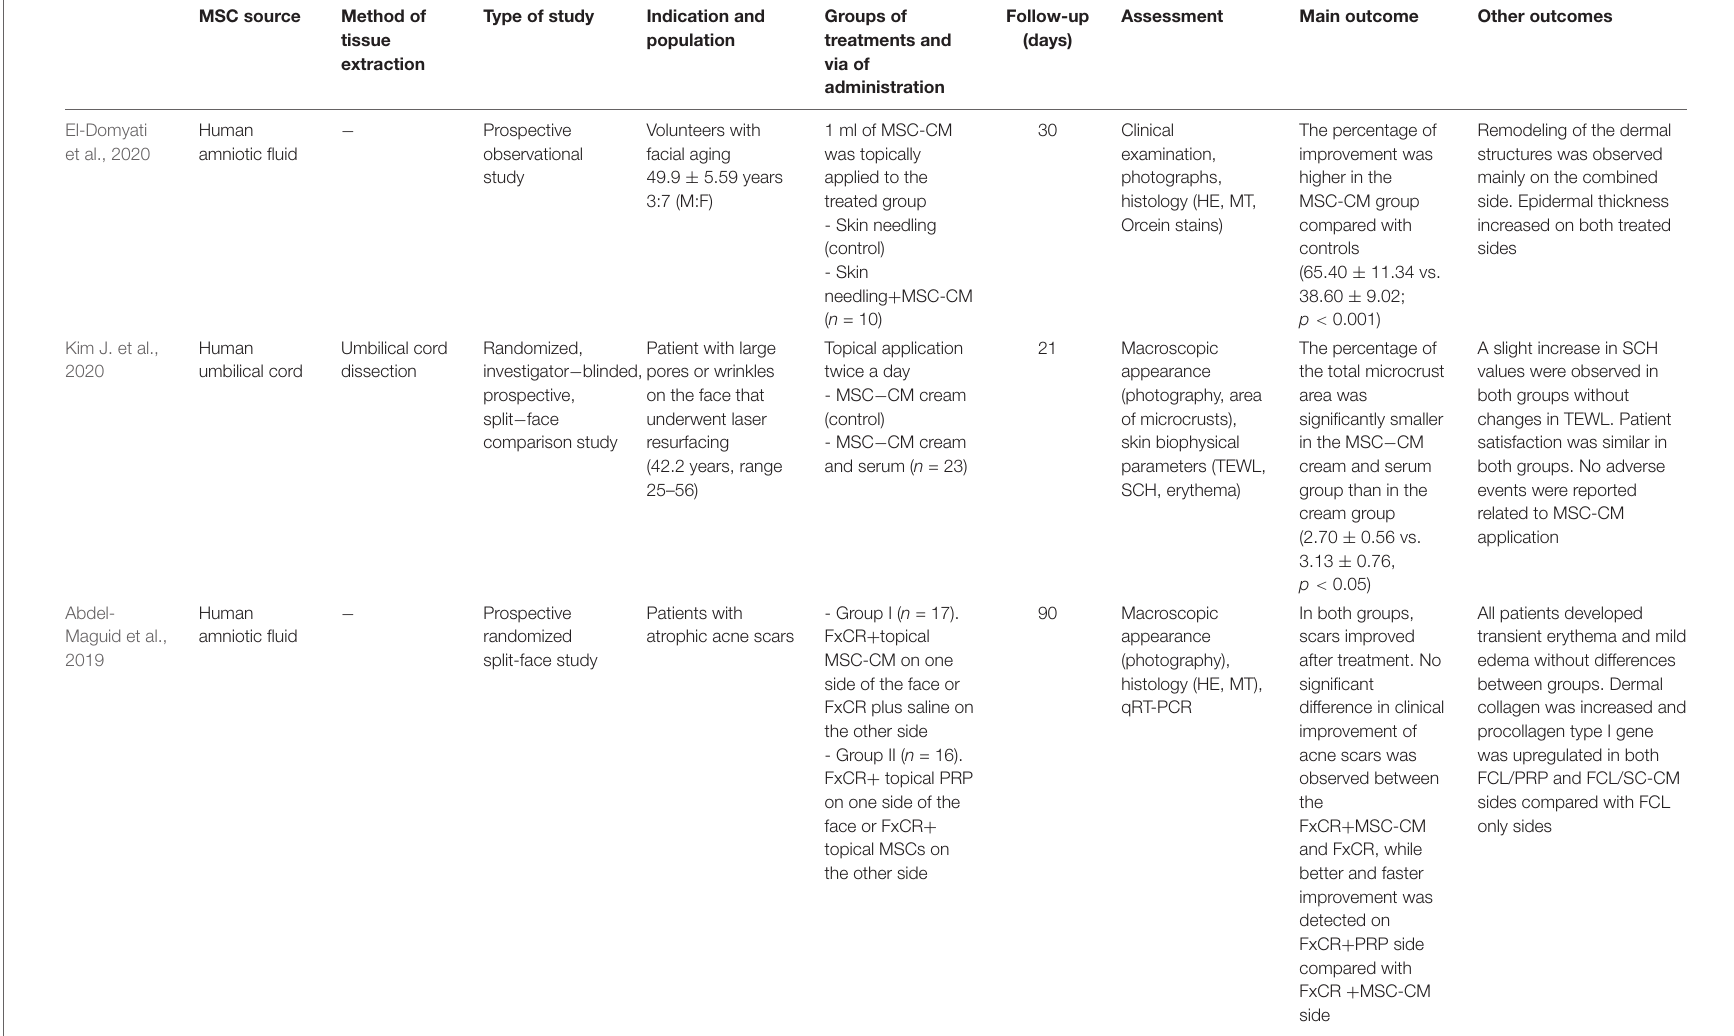
TABLE 10 | Studies regarding mesenchymal stromal cell-conditioned medium for skin rejuvenation in